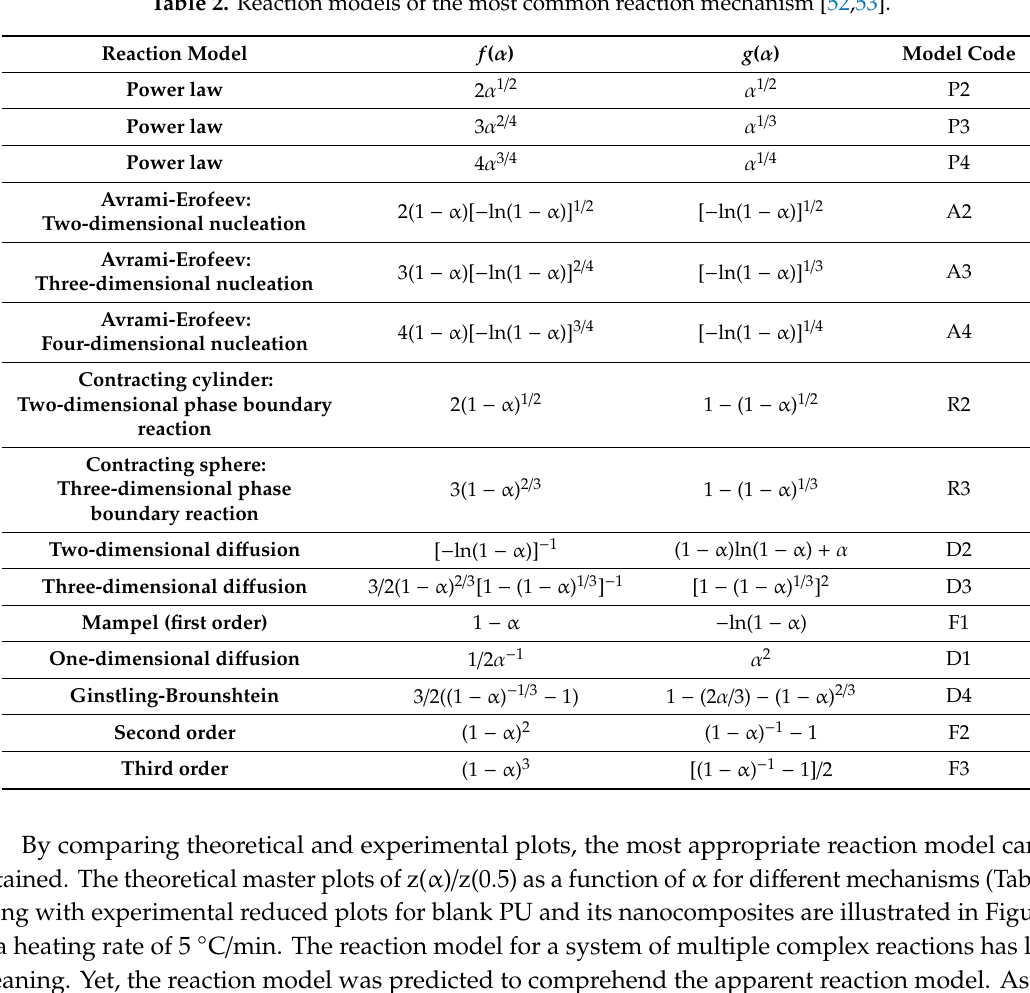
Table 2. Reaction models of the most common reaction mechanism [52,53].